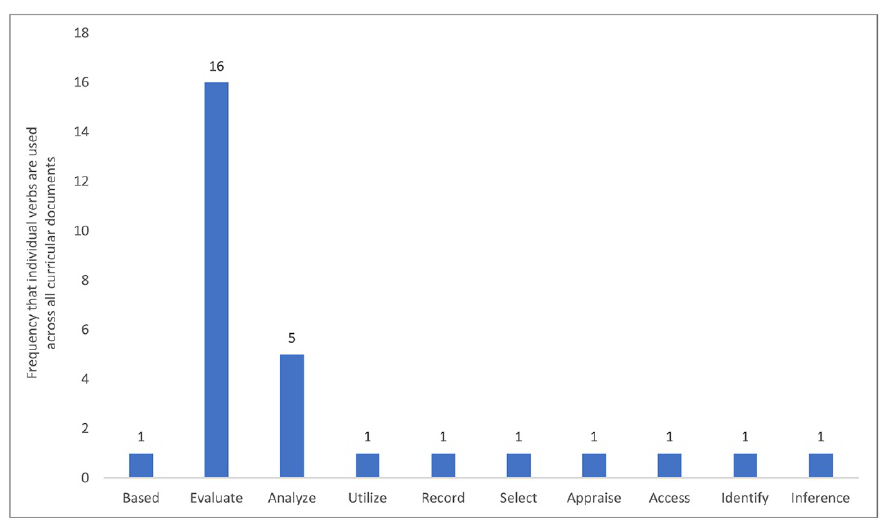
Figure 2 Analytic coding of action verbs used to describe information skills or behaviors in the professional program curricular